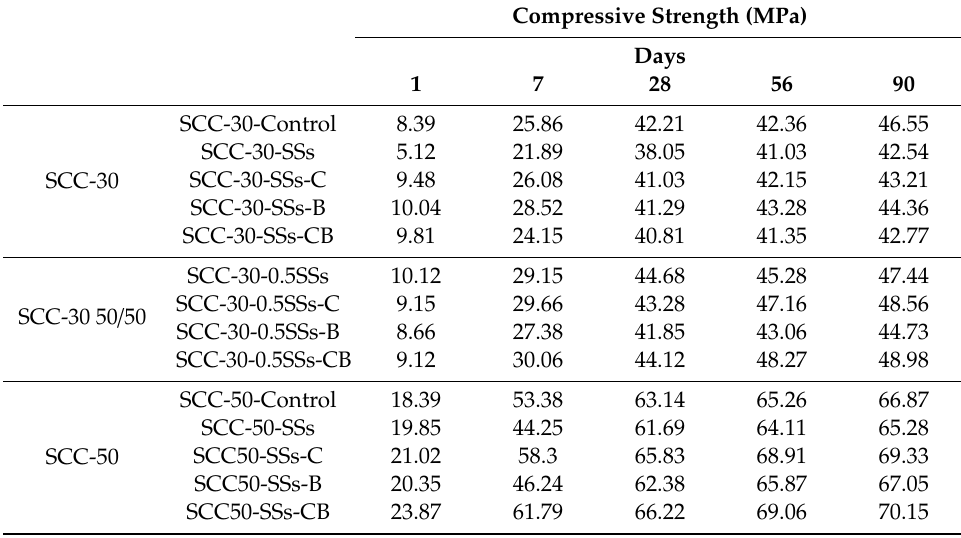
Table 6. Compressive strength of SCC.